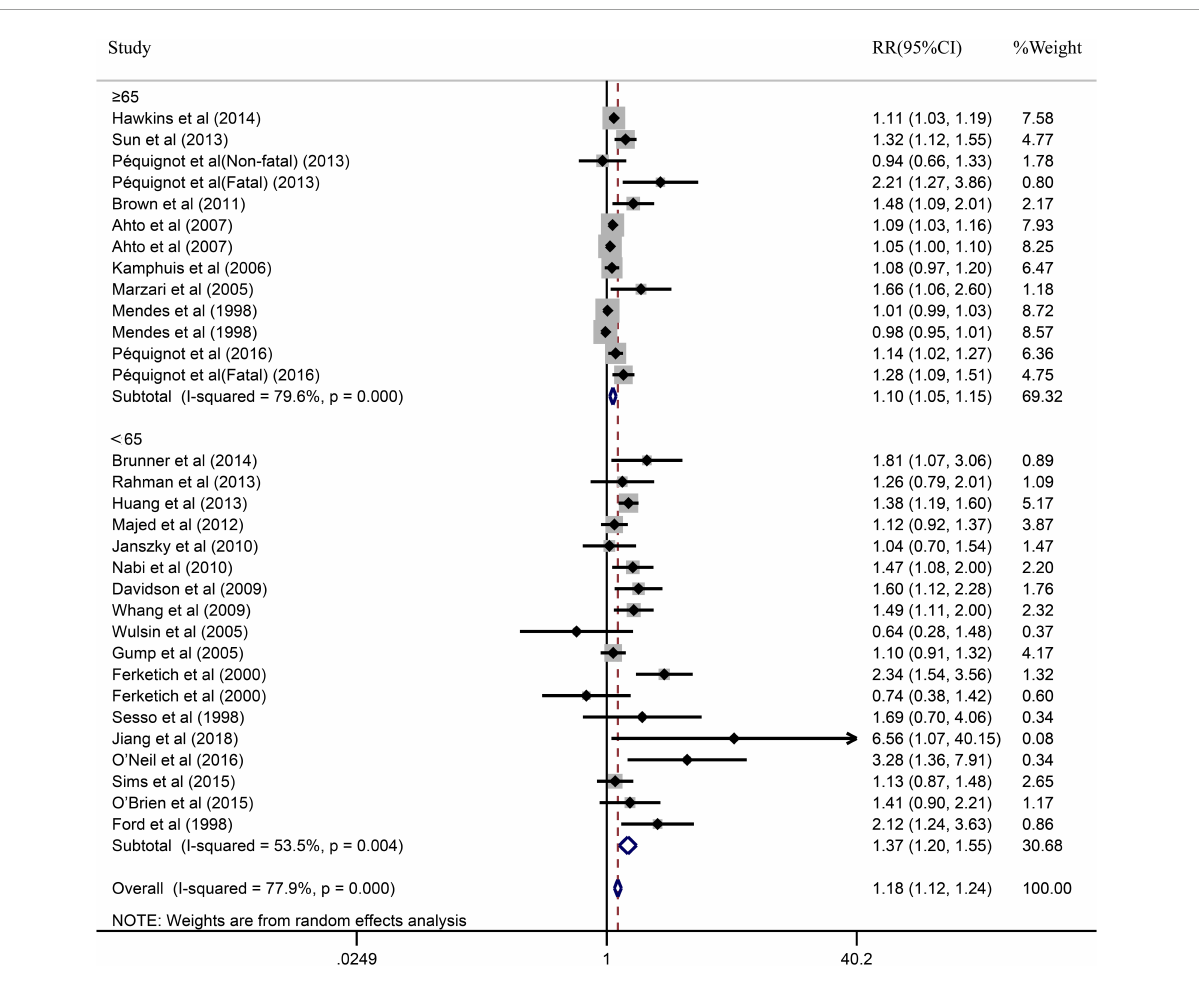
FIGURE3 Subgroup analysis with age ( ≥ 65 or < 65) presents the association between depression and the risk of coronary heart disease in a prospective cohort